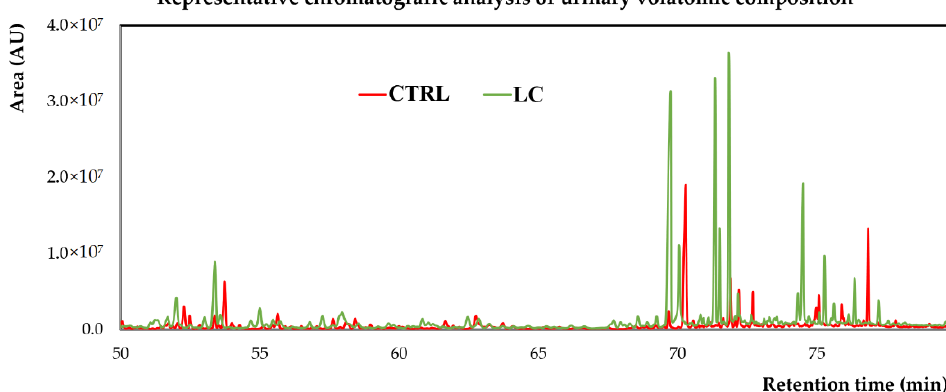
Figure 2. Representative chromatogram of urine sample from a control subject (CTRL) and a LC patient. AU—arbitrary units.